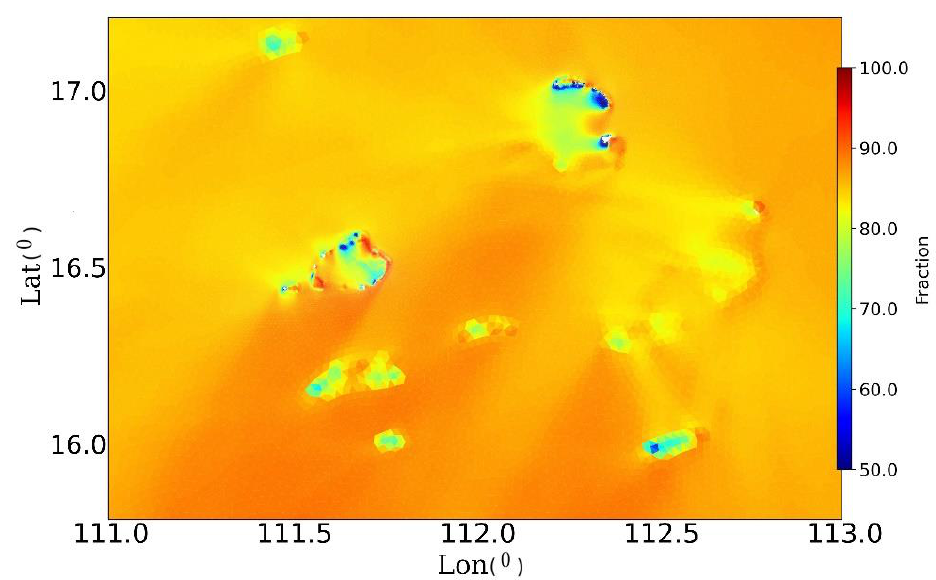
Figure 10. Distribution of annual mean wind wave ratio coefficient in the Xisha Islands.